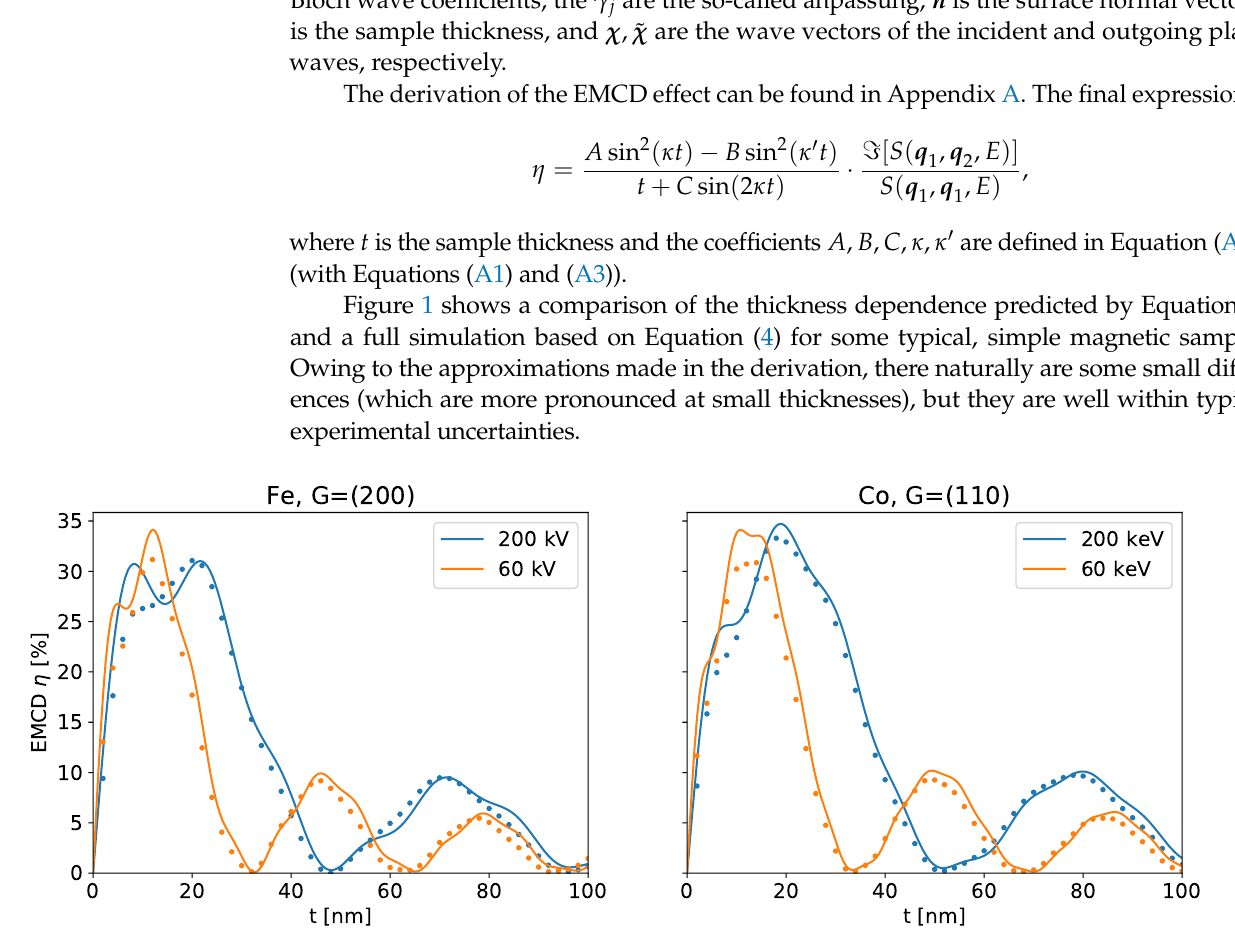
Figure 1. Comparison of the thickness dependence of the EMCD effect η predicted by Equation (7) (solid lines) and by the “bw” software using Equation (4) (dotted lines) for different acceleration voltages for bcc Fe and hcp